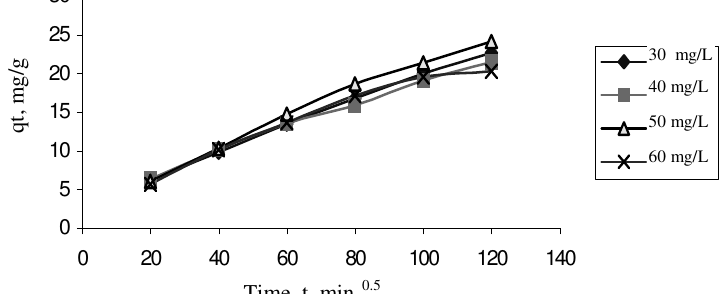
Figure 3. Plots of q (mg g -1 ) vs . t 0.5 for evaluating intra-particle diffusion rate constant t (Grey BL concentration 40 mg/L, temperature 300 K)